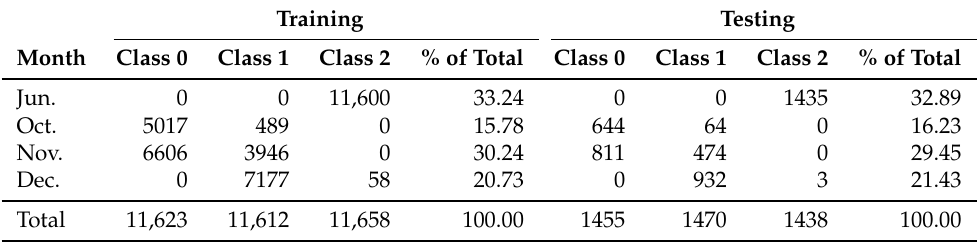
Table 6. DenseNet DBDDCA (3 class, 2 channel) monthly count breakdown.